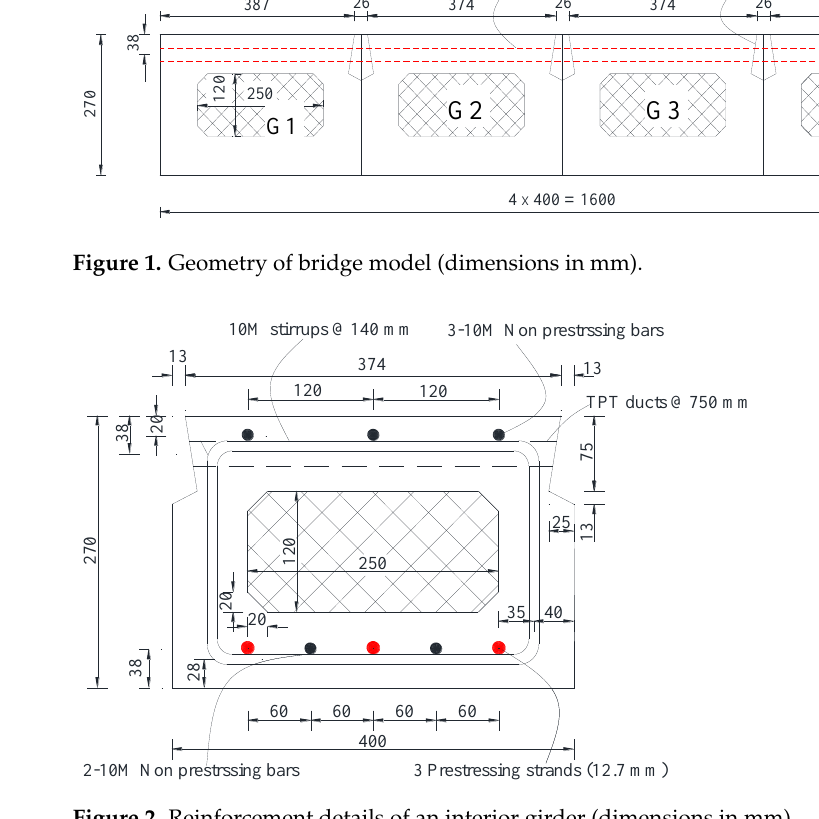
Table 1. Mechanical properties of used